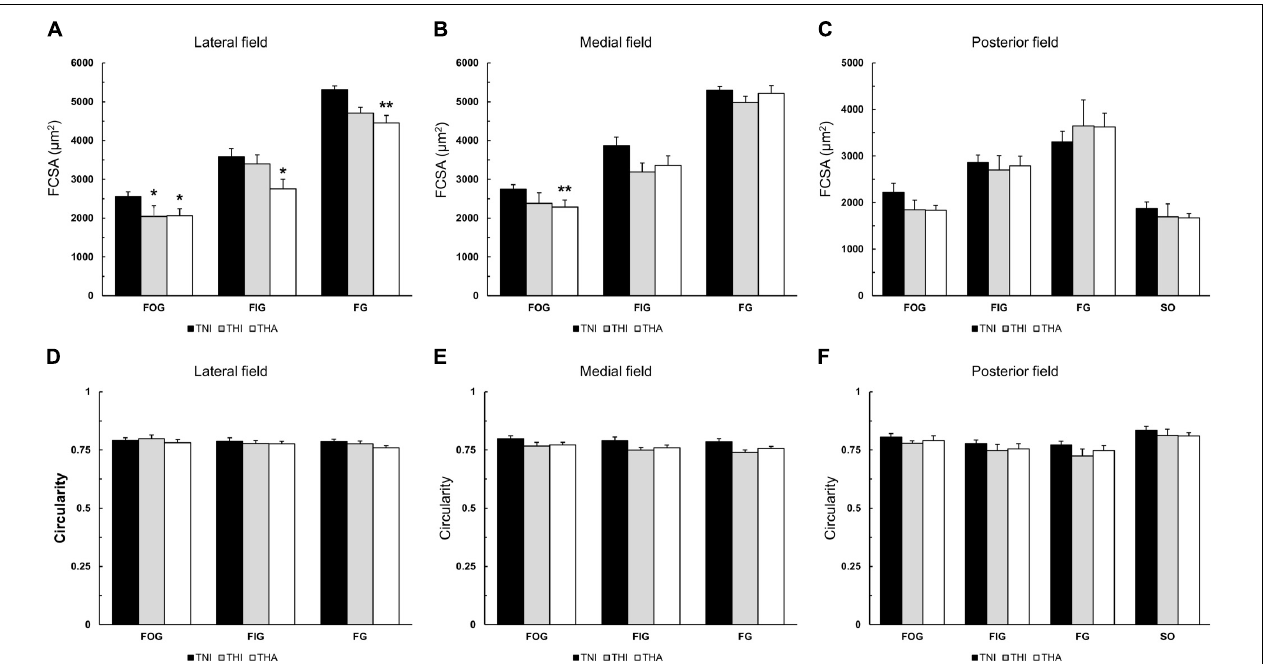
FIGURE 4 | Effects of intermittent hypobaric hypoxia (IHH) alone or in combination with light aerobic exercise on the mean fiber cross-sectional area (A–C) and fiber shape (D–F) in three TA muscle regions from trained rats. ∗ and ∗∗ indicate P < 0.05 and P < 0.01, respectively, compared to TNI rats. TNI , trained normobaric inactive; THI , trained hypobaric inactive; THA , trained hypobaric active.